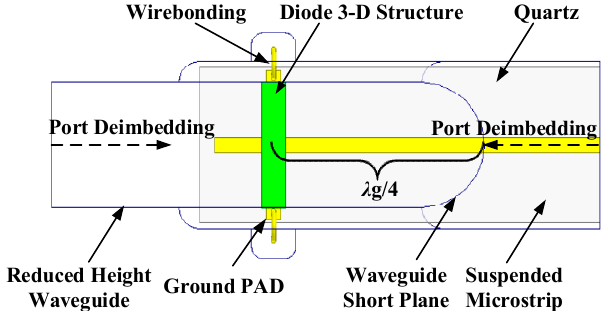
Figure 2. The 3-D EM model of the diodes in balanced structure in HFSS. Table 2. Some key SPICE parameters of the diodes.